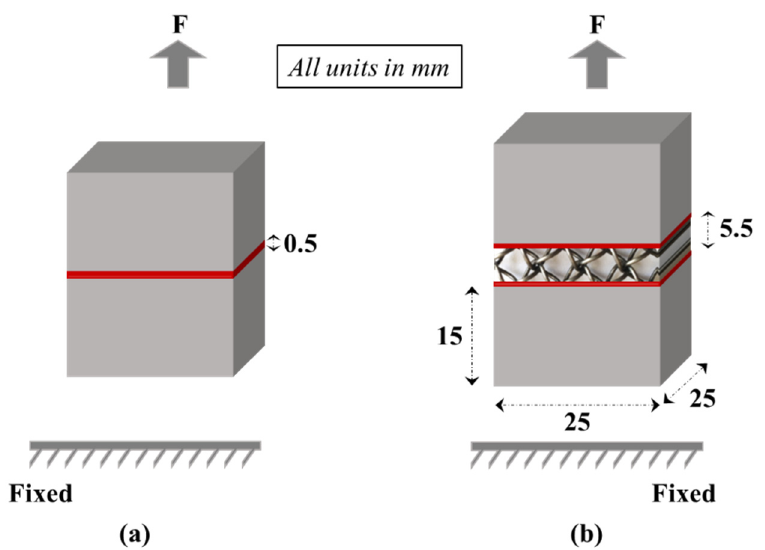
Figure 4. Schematic setup of ( a ) the steel block joint without 3D TWS and ( b ) the steel block joint